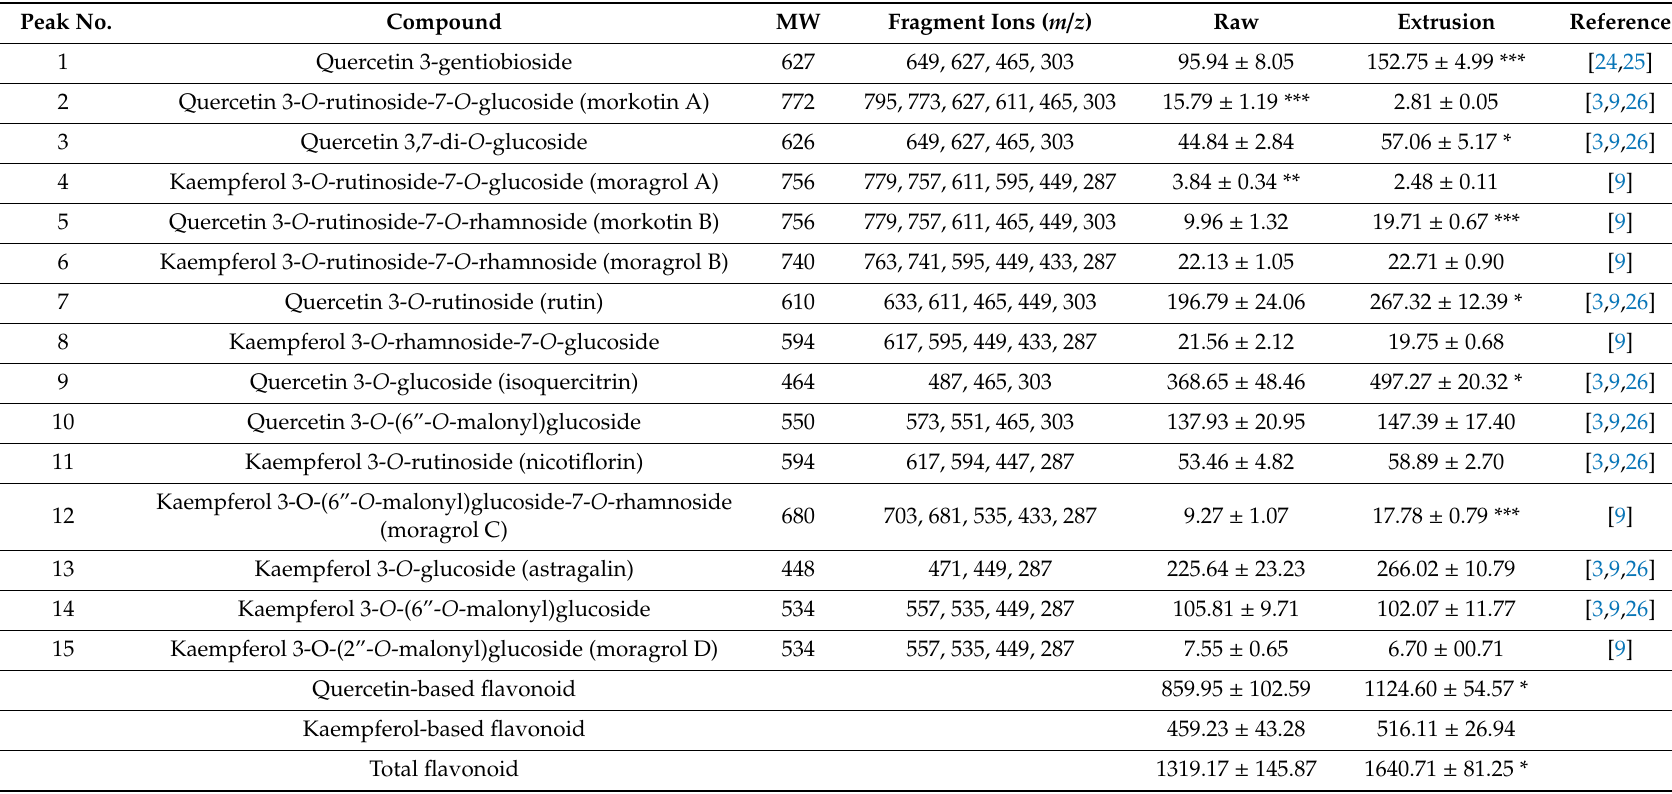
Table 3. Contents of flavonoids (mg 100 g / dry weight) isolated from optimal extruded mulberry leaves extract. Peak